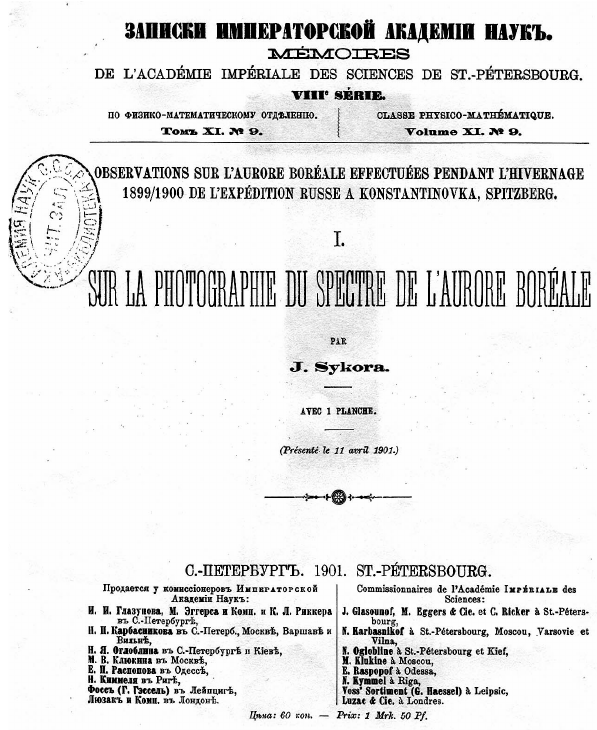
Fig. 3. Cover of J. Sykora’s report in the Russian Imperial Academy proceedings.